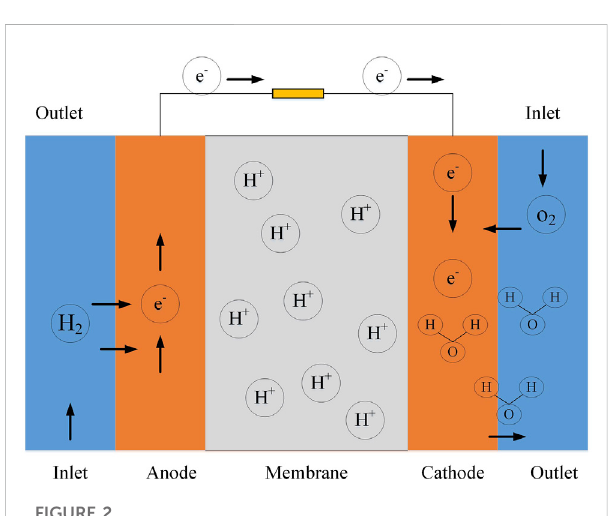
FIGURE 2 Chemical reaction of the PEMFC (Ang, Salem et al.,